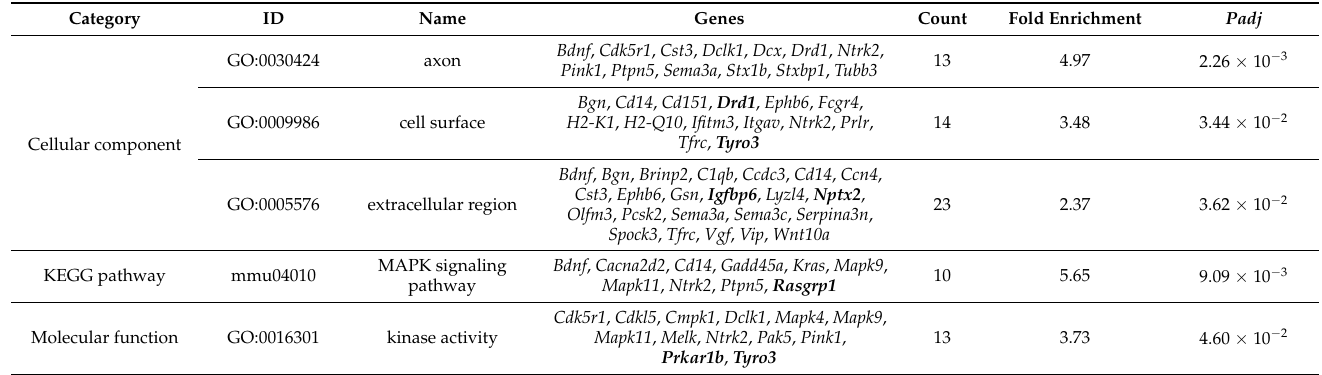
Genes belonging to the core signature (Tables S11 and S12: genes with absolute scores ≥ 6, Figure 3) are in